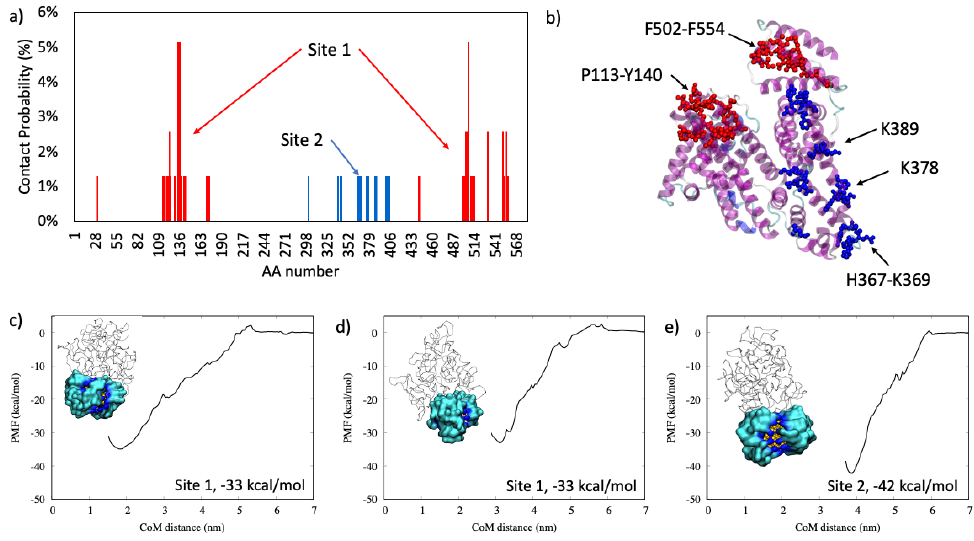
Figure 2. In panel ( a ): the contact probability for each residue upon serum albumin binding to all-MUS AuNP. Amino acids belonging to Site 1 are colored in red, while those of Site 2 are colored in blue. In panel ( b ): the graphical representation of the most probable binding sites in VdW, colored according to the binding site. In panels ( c – e ): the two binding modalities with the relative PMF curve.